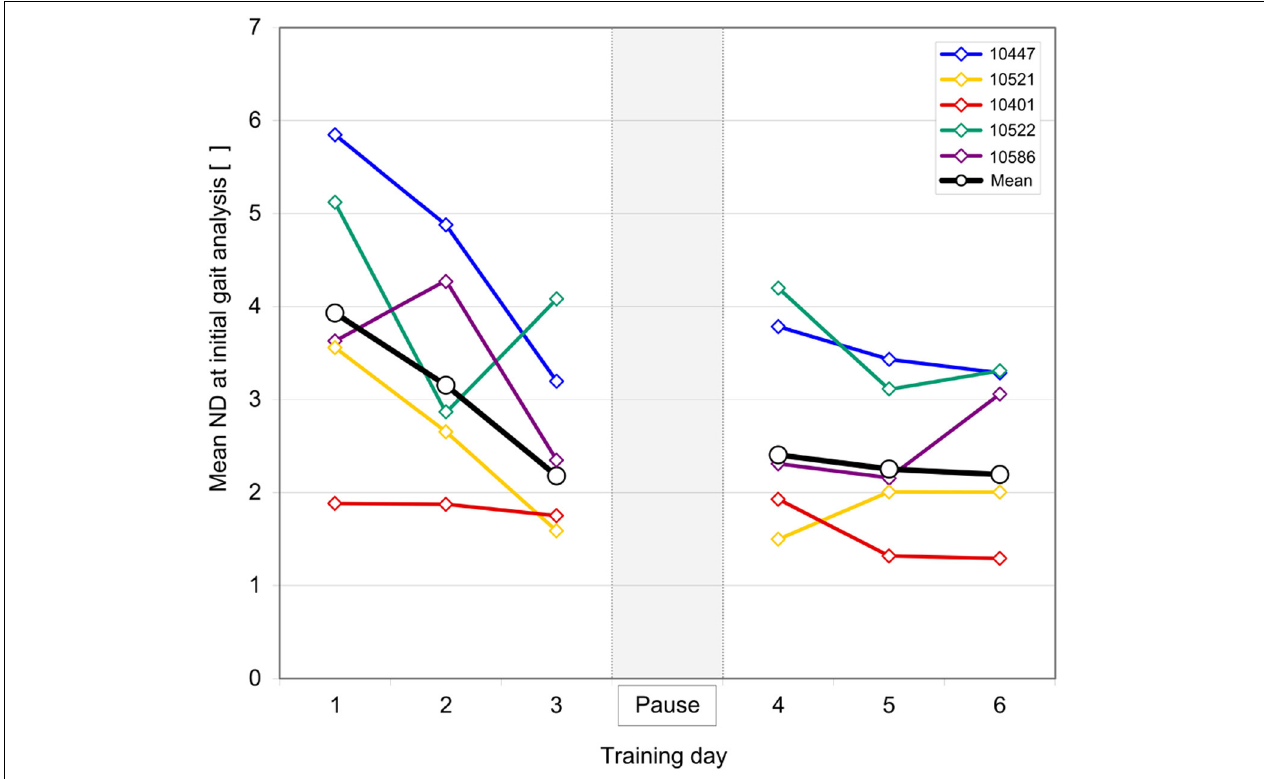
FIGURE 5 | Learning curves of individuals with iSCI over 6 days of training with a 2 weeks pause in between. Norm distance (ND) values were derived from initial gait analysis (without feedback) preceding every feedback session. Brown lines indicate mean ND over all individuals with